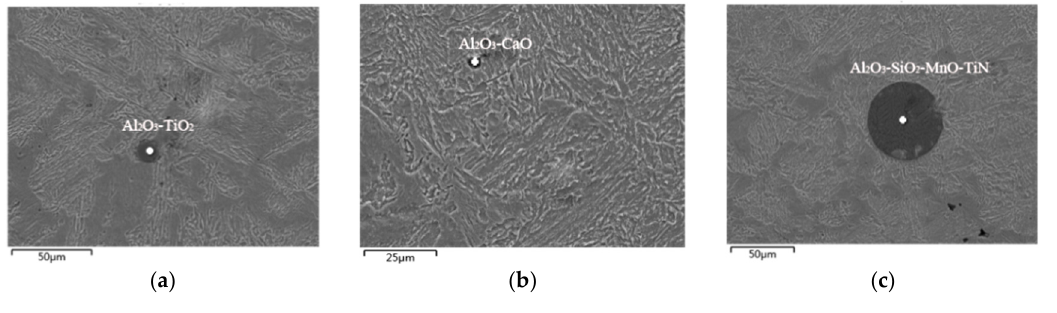
Figure 8. SEM and EDS analysis of inclusions in tundish. ( a ) Al 2 O 3 -TiO 2 ; ( b ) Al 2 O 3 -CaO; ( c ) Al 2 O 3 - SiO 2